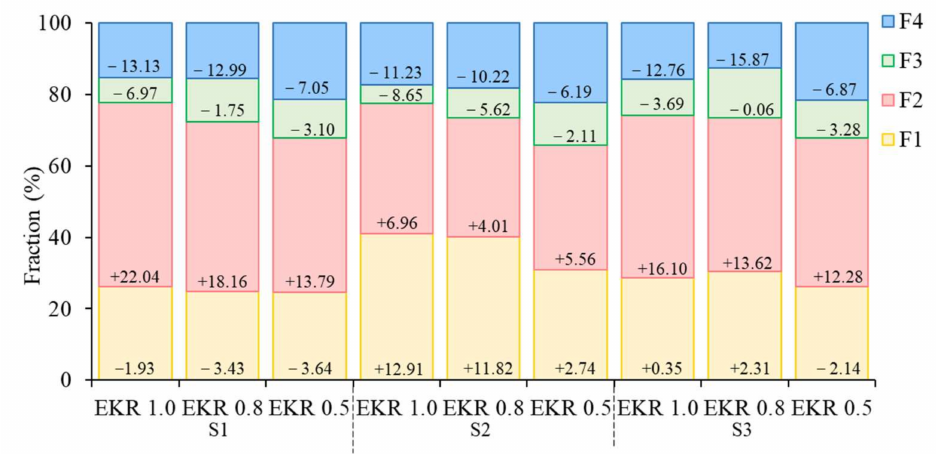
Figure 4. Cd fractions (%) at the end of EKR process. Figures in the graph indicated the variations of different fractions of Cd compared to the initial one. “+” indicates increase in the percentage, and “ − ” indicates the decrease in the percentage. EKR indicates electrokinetic remediation. F1-Cd, F2-Cd, F3-Cd, and F4-Cd indicate the exchangeable fraction, reducible fraction, oxidizable fraction, and residual,